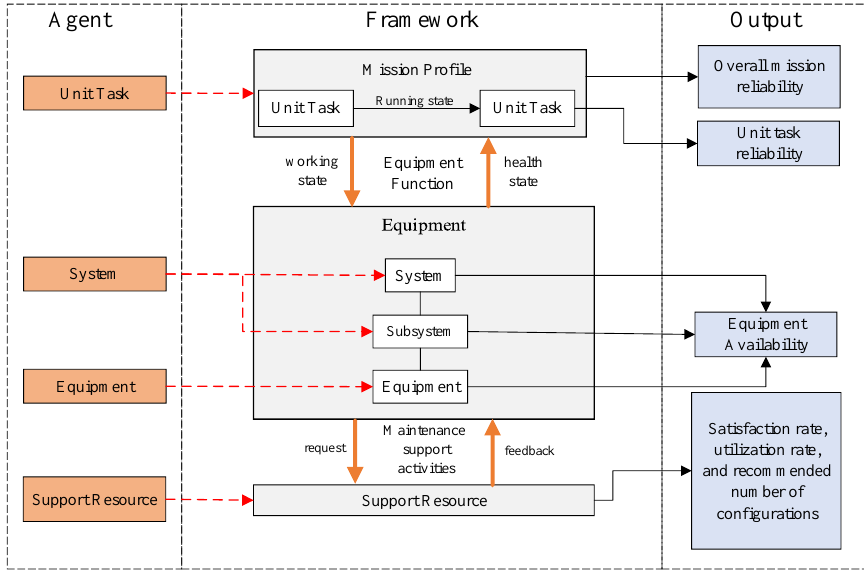
Figure 1. Framework of warship mission reliability simulation system based on agent.